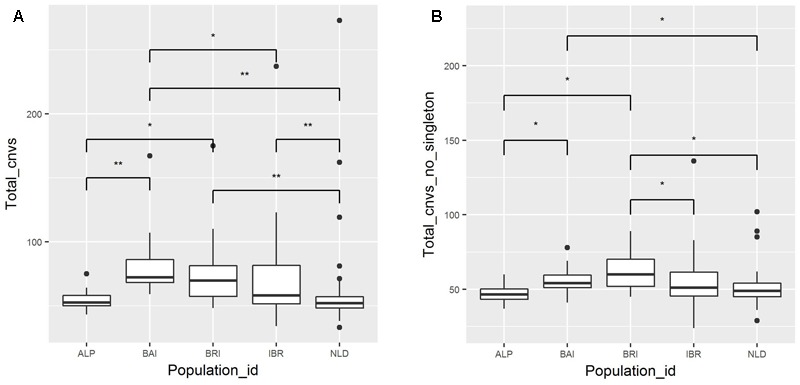
Number of detected CNVs per sample. Samples are categorized based on their origins. The median of the population is indicated by central line in a box, while the black dots represents outliers. Connecting bar above box plots between pair of populations displays significant P-values. “∗” Indicates P < 0.05 and “∗∗” indicates P < 0.01. (A) Total CNV counts with singleton. (B) Total CNV abundance excluding singleton.